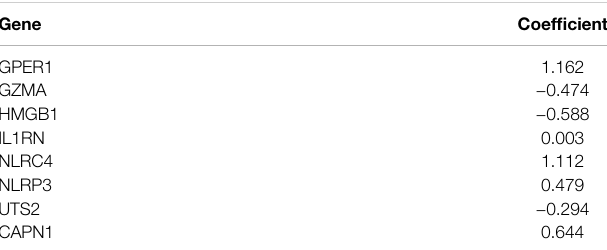
TABLE 5 | The coef fi cient of eight